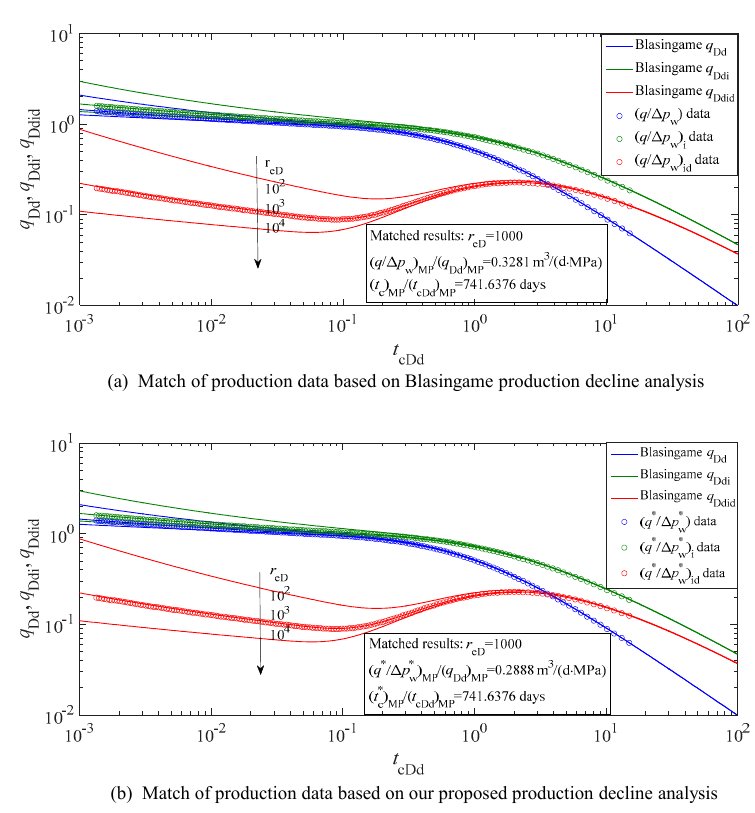
Figure 9. Match of production data for CPP case of ∆ p w = 50